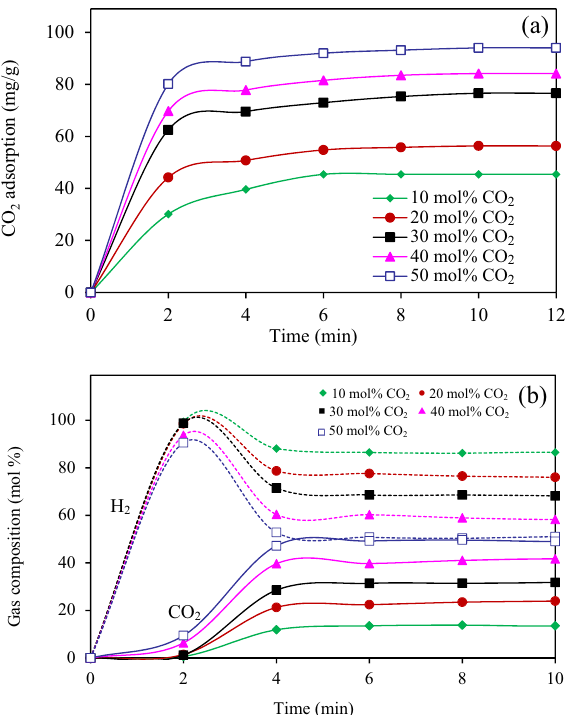
Figure 9. ( a ) CO 2 adsorption capacity of 12MgO/AC from the biohydrogen and ( b ) exit gas concentrations at different CO